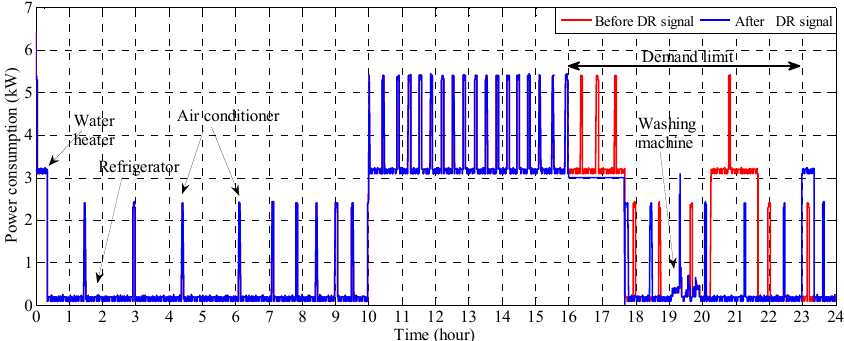
Figure 26. Total power consumption before and after DR signal with the hybrid LSA ‐ ANN.